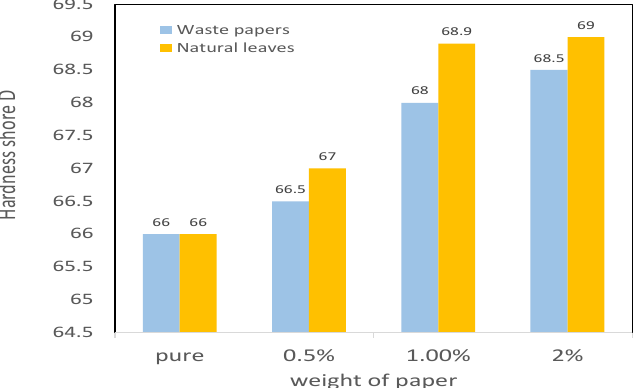
Fig. 11: Hardness of the reinforced cement